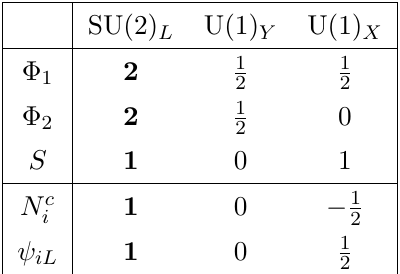
Table 1 . Transformation properties of the scalar and fermion (cid:12)elds under SU(2) L (cid:2) U(1) Y (cid:2) U(1) X . mass matrix. Section 3 is devoted to the theoretical and experimental constraints